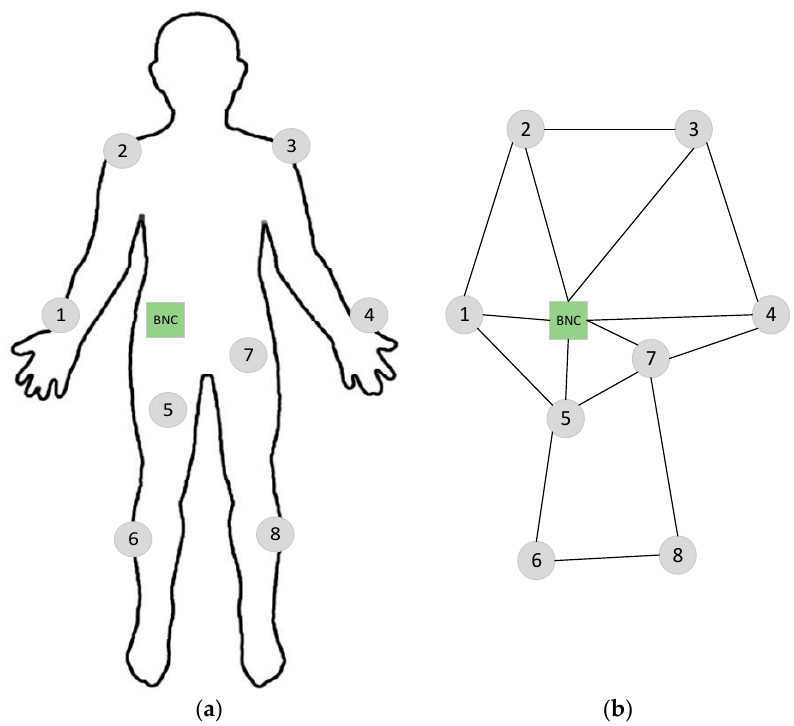
Figure 2. Network topology ( a ) Physical Topology ( b ) Logical topology .